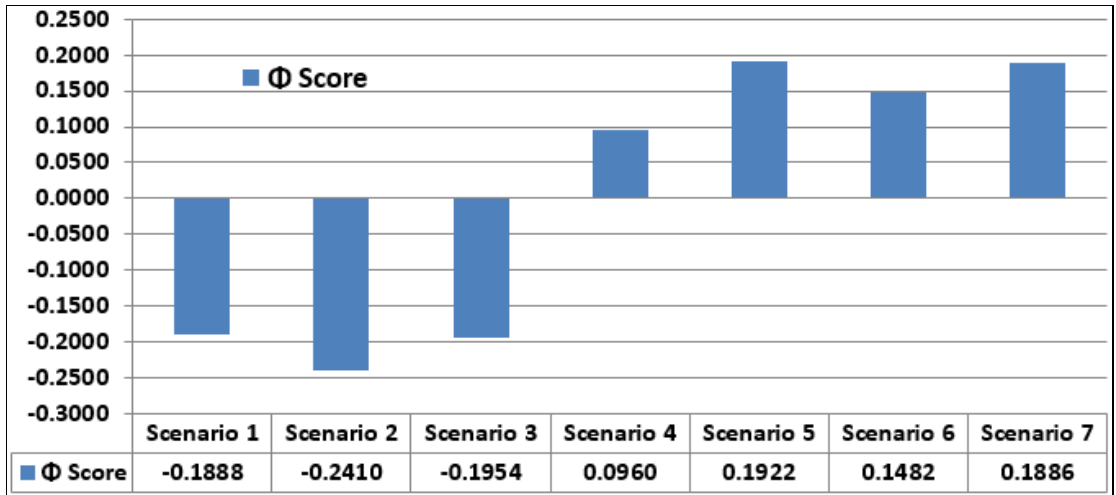
Figure 3. Ranking of hybrid water supply scenarios.